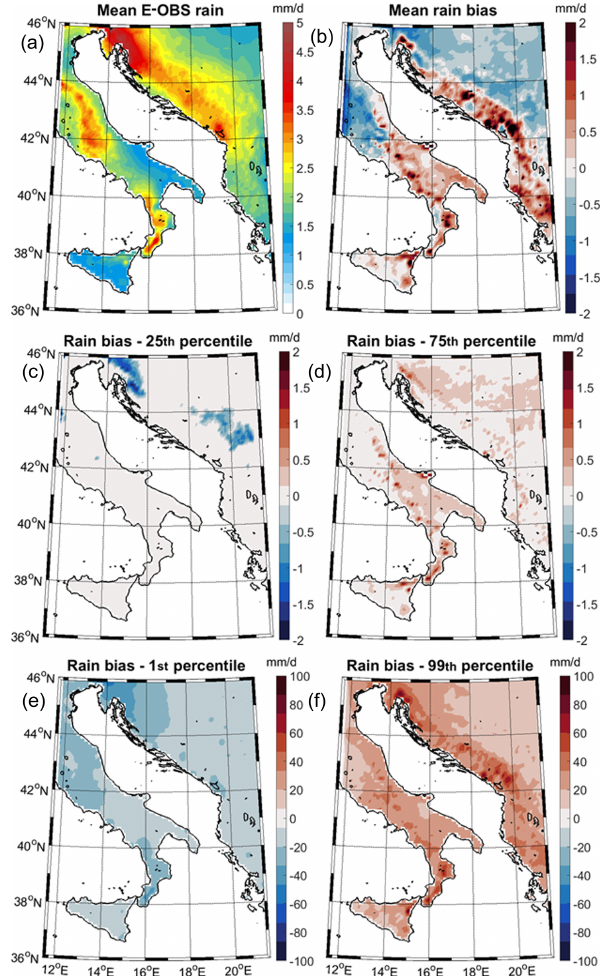
Figure 4. Median of the E-OBS daily mean temperature dataset over the land (a) and median (b) and 25th (c) , 75th (d) , 1st per- centile (e) , and 99th (f) percentiles of the daily temperature biases between AdriSC WRF 3km model results and the E-OBS dataset over the land during the 1987–2017 period.